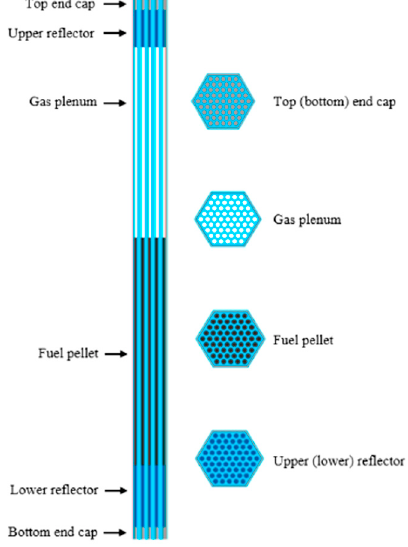
Figure 2. Fuel assembly configuration. Table 2. Design parameters of the fuel Table 1. Design parameters of the core.